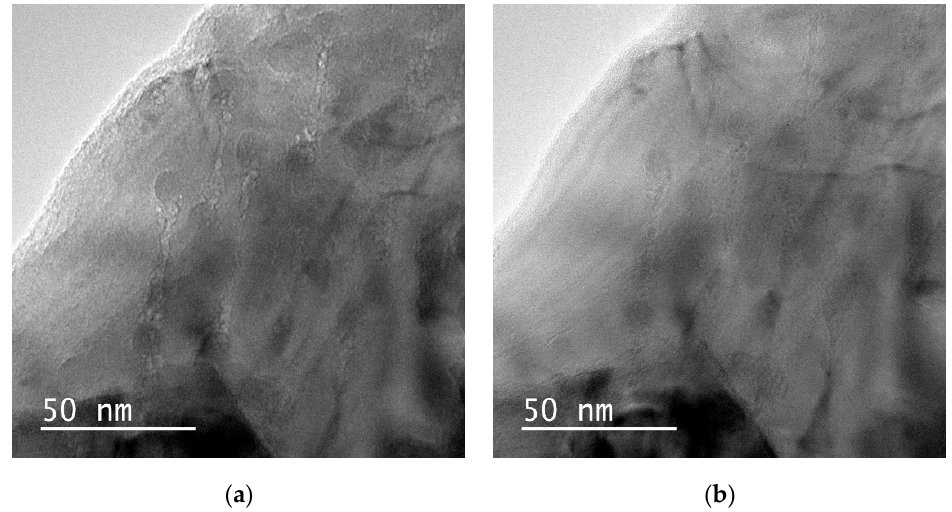
Figure 4. Bright field images of ion tracks induced in SrTiO 3 irradiated with 200 MeV Au 32+ at an oblique incidence angle. The images were taken in ( a ) underfocus and ( b ) overfocus conditions.